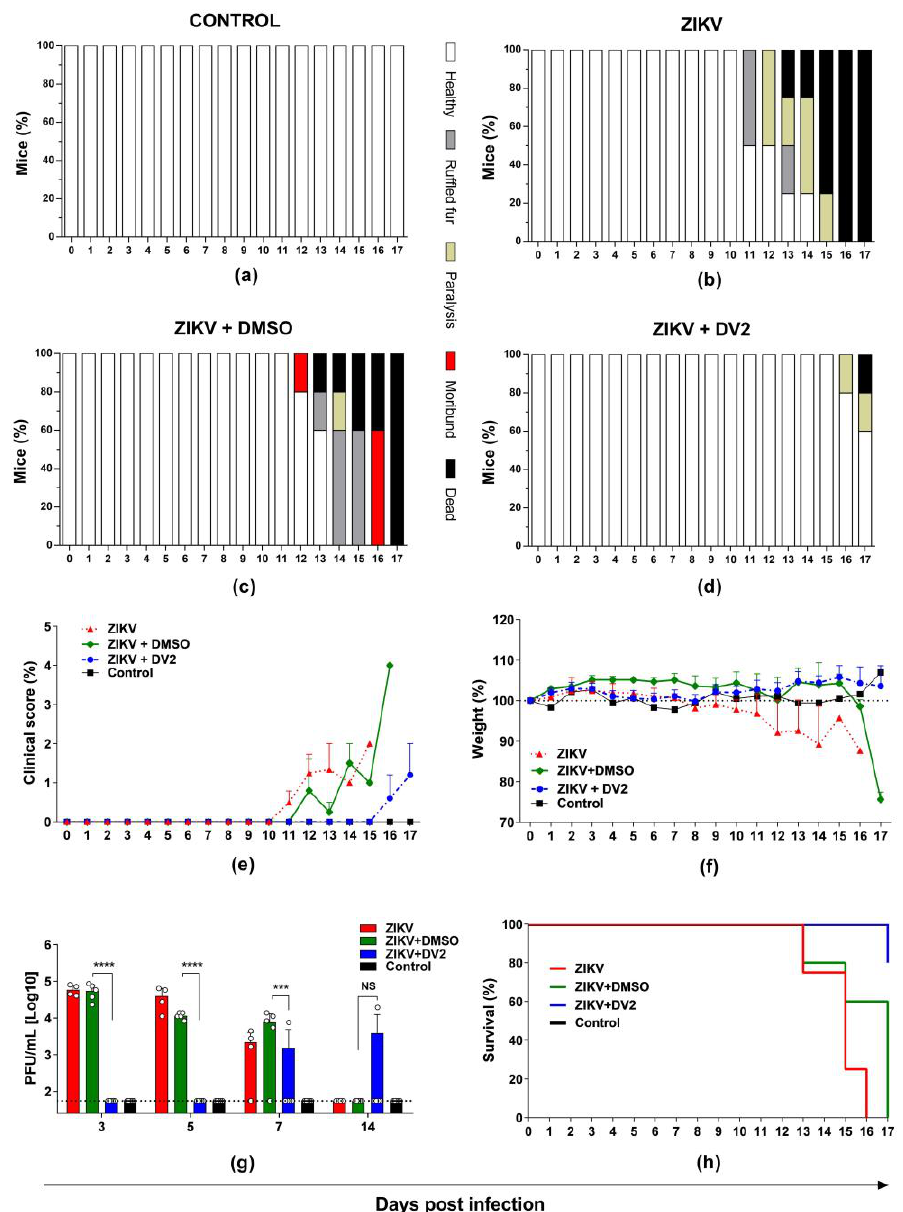
Figure 4. The DV2 peptide induces protection against ZIKV infection in AG129 mice. DV2 (12 µM) was incubated with 100 PFU ZIKV BR for 30 min at 37 °C. The virus-peptide mixtures were s.c. inoculated in AG129 mice. The ( a – d ) morbidity, ( e ) clinical score, ( f ) weight changes, ( g ) viremia, and ( h ) survival were monitored in the infected animals for up to 17 days. The data are presented as means ± SD of the respective parameters in the different mice groups. Statistical significance was evaluated using two-way ANOVA followed by Bonferroni correction. Mantel-Cox test was used to analyze the survival results (*** p < 0.001; **** p < 0.0001; NS, not